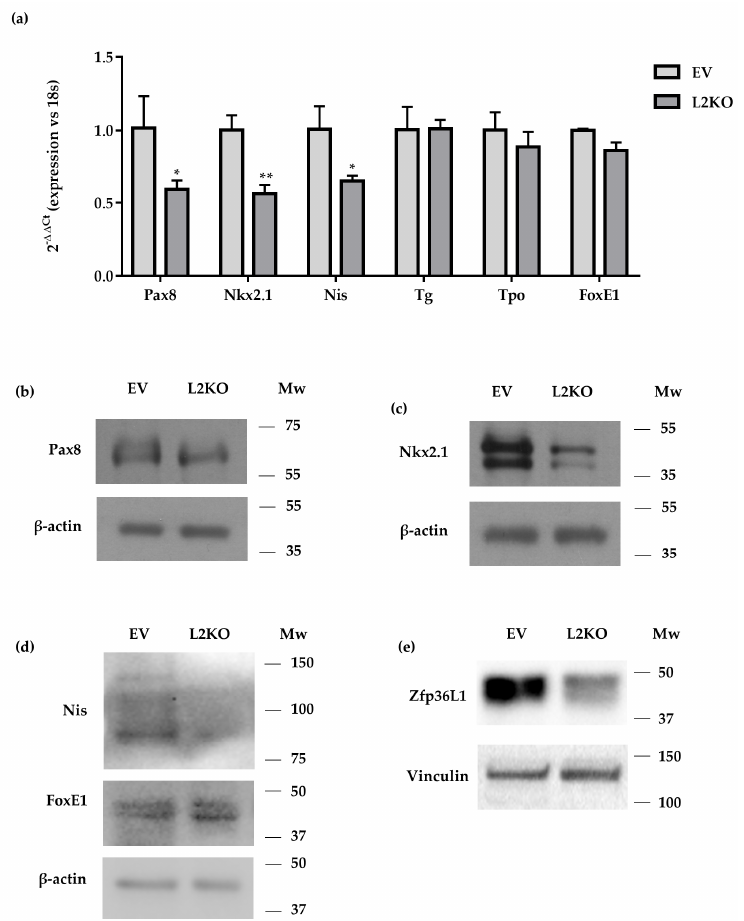
Figure 6. Analysis of thyroid-specific/enriched genes. Gene expression ( a ) or protein ( b – d ) in L2KO and bulk culture vs. EV cells. ZFP36L1 levels were also tested by Western blotting ( e ). RTqPCR data are reported as mean ± standard deviation of ∆∆ Ct values (FC values of gene normalized vs. FC values of 18SrRNA to obtain ∆ Ct values of samples; ∆ Ct values of KO samples are then normalized vs. ∆ Ct of control samples to obtain ∆∆ Ct values) in KO ( n = 3) and controls ( n = 3). * p < 0.05; ** p <